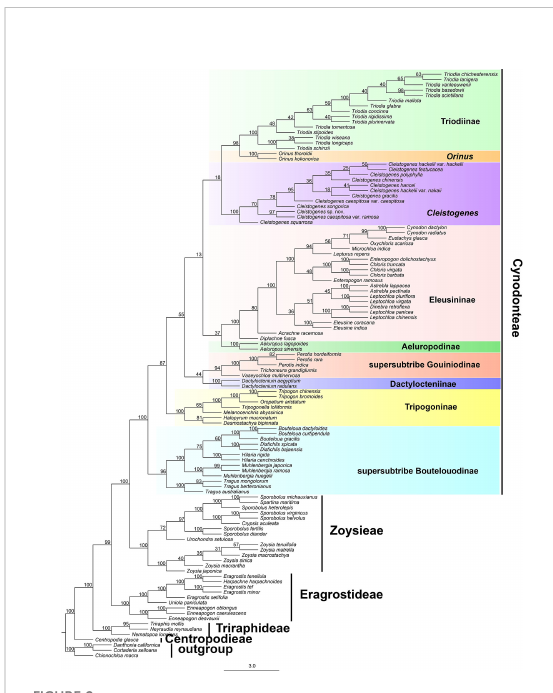
FIGURE 2 Phylogeny estimated under the multispecies coalescent with ASTRAL from ML gene trees. Values above internodes are bootstrap values (BS).